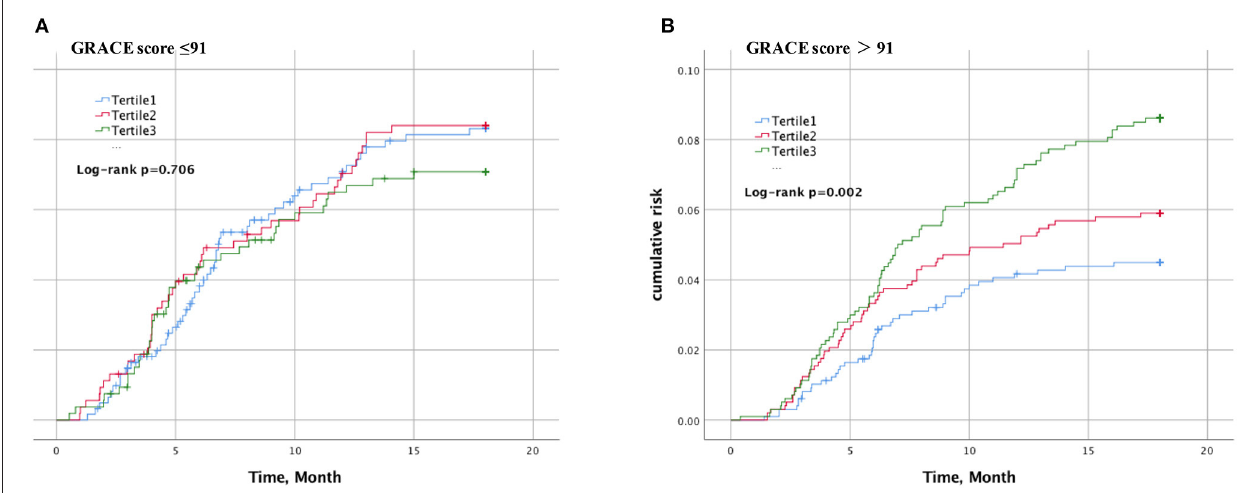
FIGURE 1 | Kaplan–Meier curve of cardiovascular events according to lipoprotein(a) and GRACE score. The cumulative incidence of cardiovascular events over time stratified by Lp(a) tertiles in the case of GRACE score 91 or less (A) or > 91 (B)